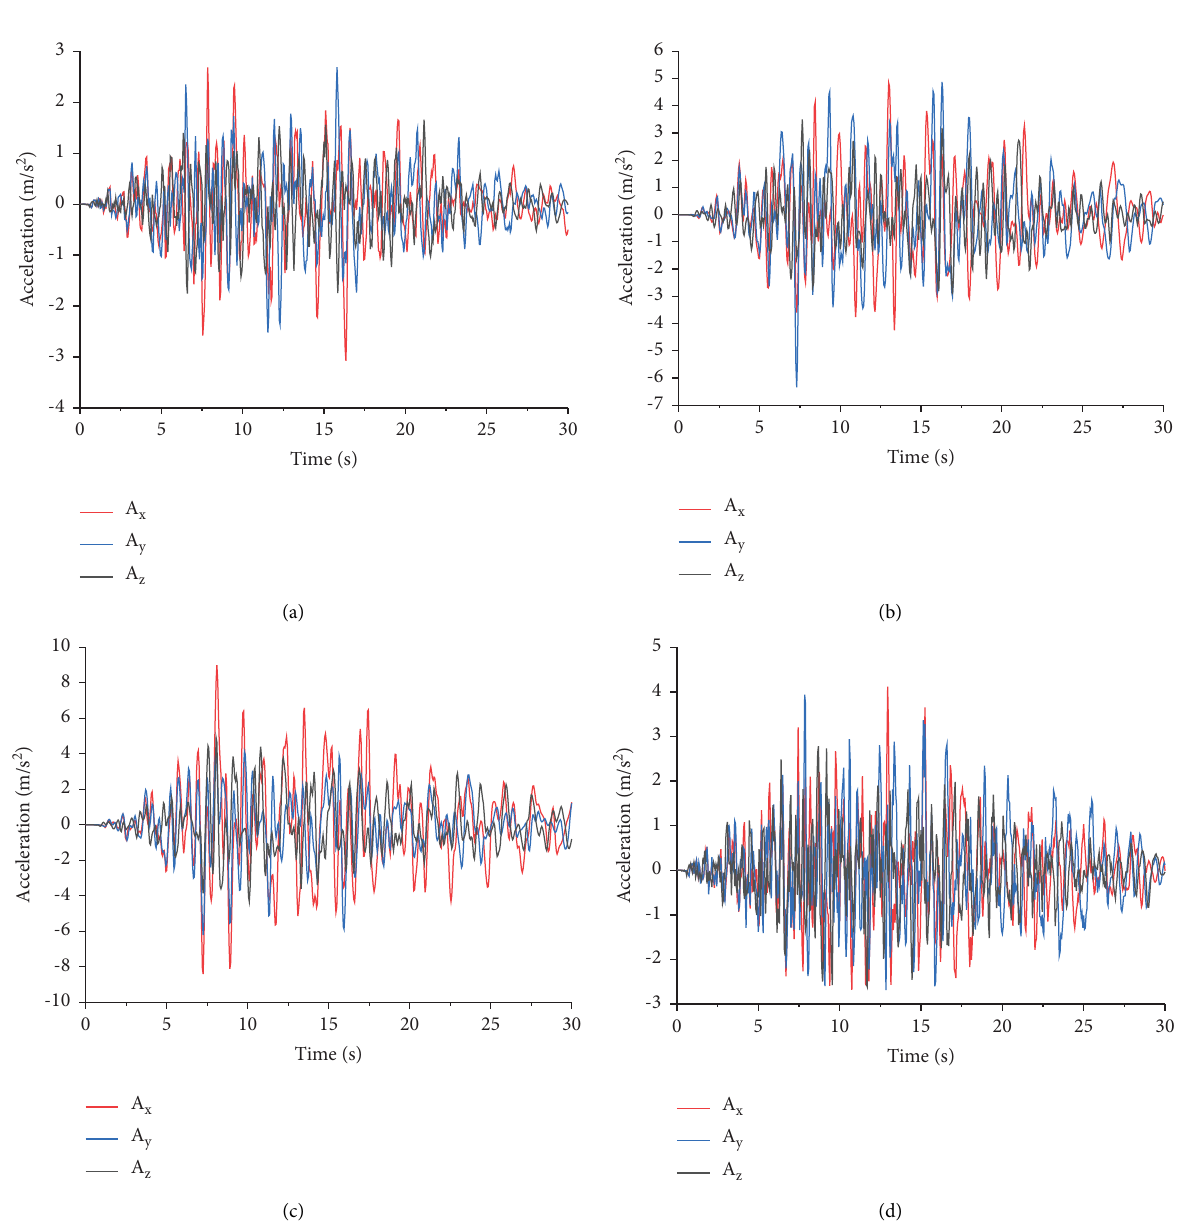
Figure 8: Acceleration time-history curve of observation point. (a) Maximum buried depth (2,481.8 m). (b) Top of the maximum buried depth (4,435.9 m). (c) Highest altitude (5,265.8m). (d) Valley (2,378.6